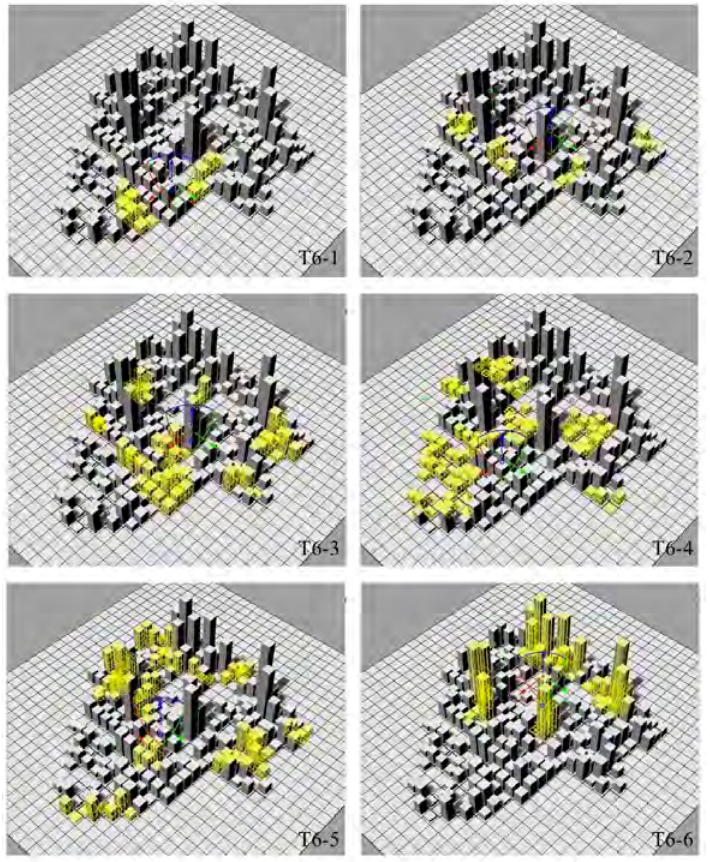
Figure 6. Parametricmodels of zone